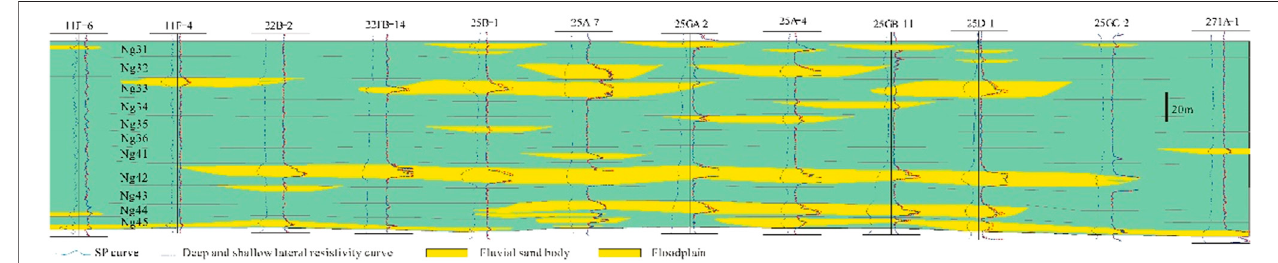
FIGURE 3 | Drilling – well logging pro fi les vertical the source direction of channel in the anatomical